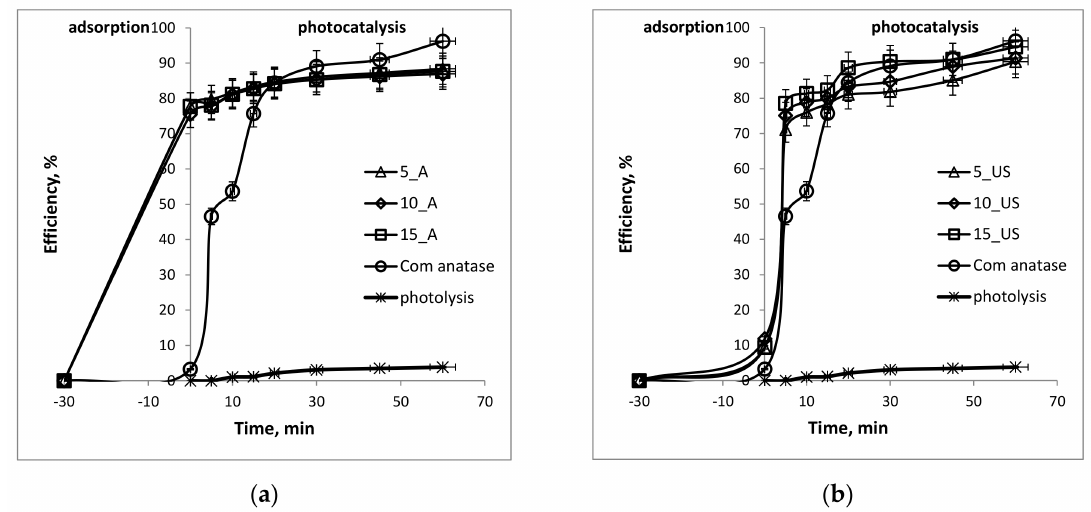
Figure 6. Photodegradation efficiency of the synthesized titania nanoparticles for degradation of MB under UV light: ( a ) TiO 2 samples of A-series; ( b ) TiO 2 samples of